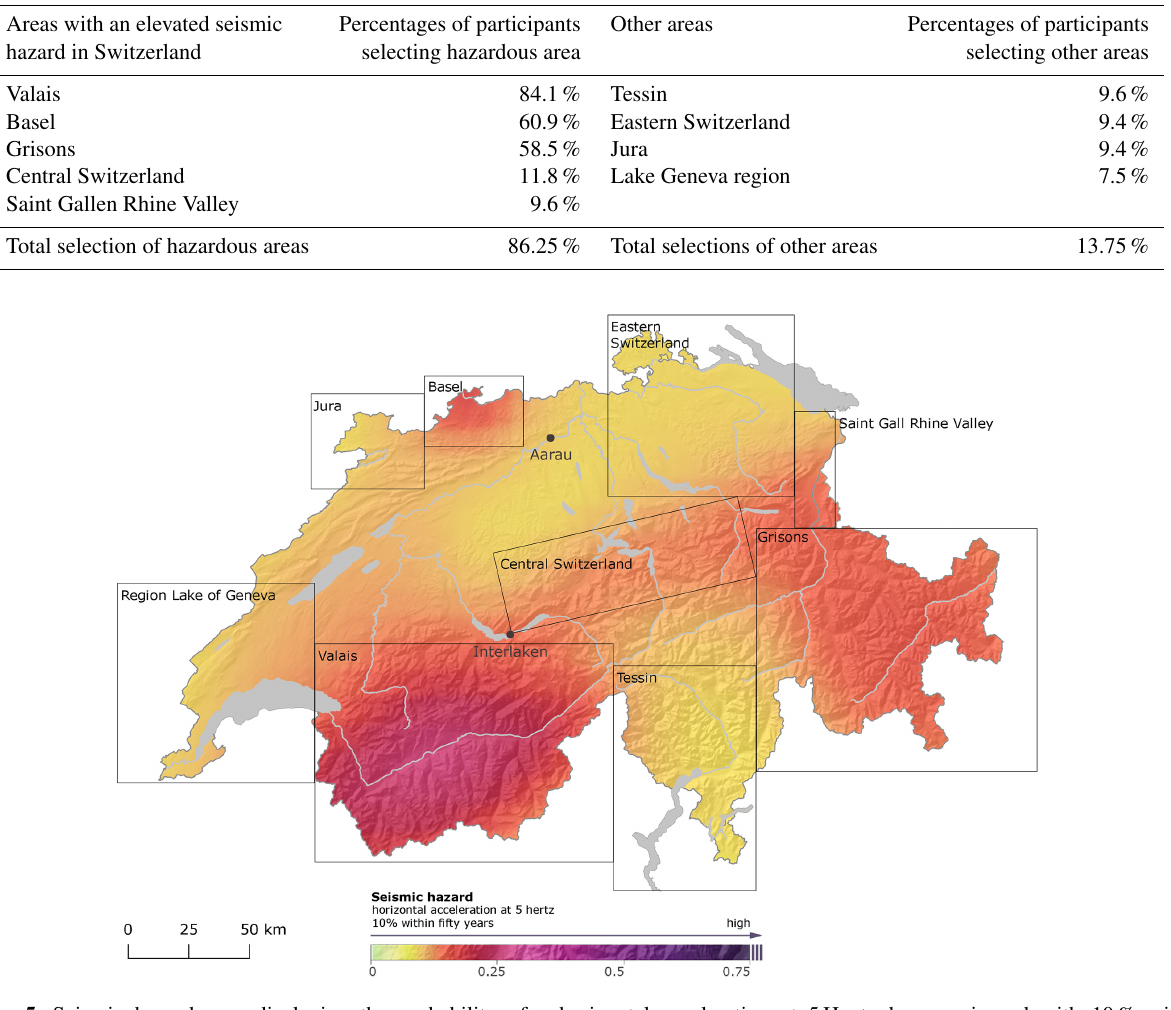
Figure 5. Seismic hazard map displaying the probability of a horizontal acceleration at 5Hz to be experienced with 10% within 50 years (475 years) on rocky subsoil and the areas in question (Swiss Seismological Service, 2018; http://www.seismo.ethz.ch/knowledge/ seismic-hazard-switzerland/maps/hazard/). The map was shown to the participants without the frames highlighting the different